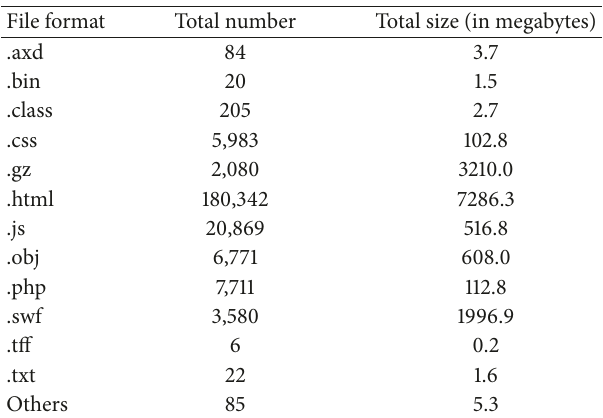
Table 3: Malicious data statistics.